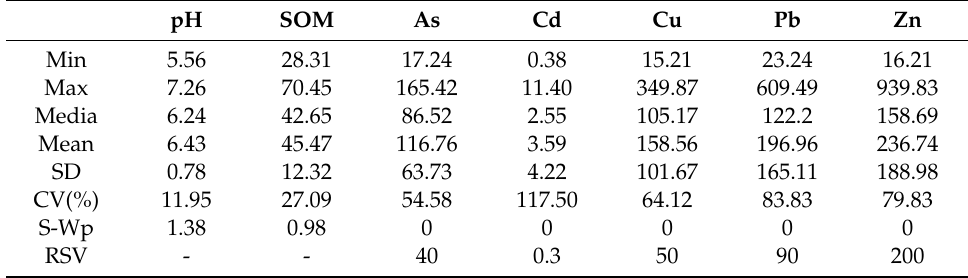
Table 1. Physicochemical characteristic of the soils from the study area (mg / kg). pH SOM